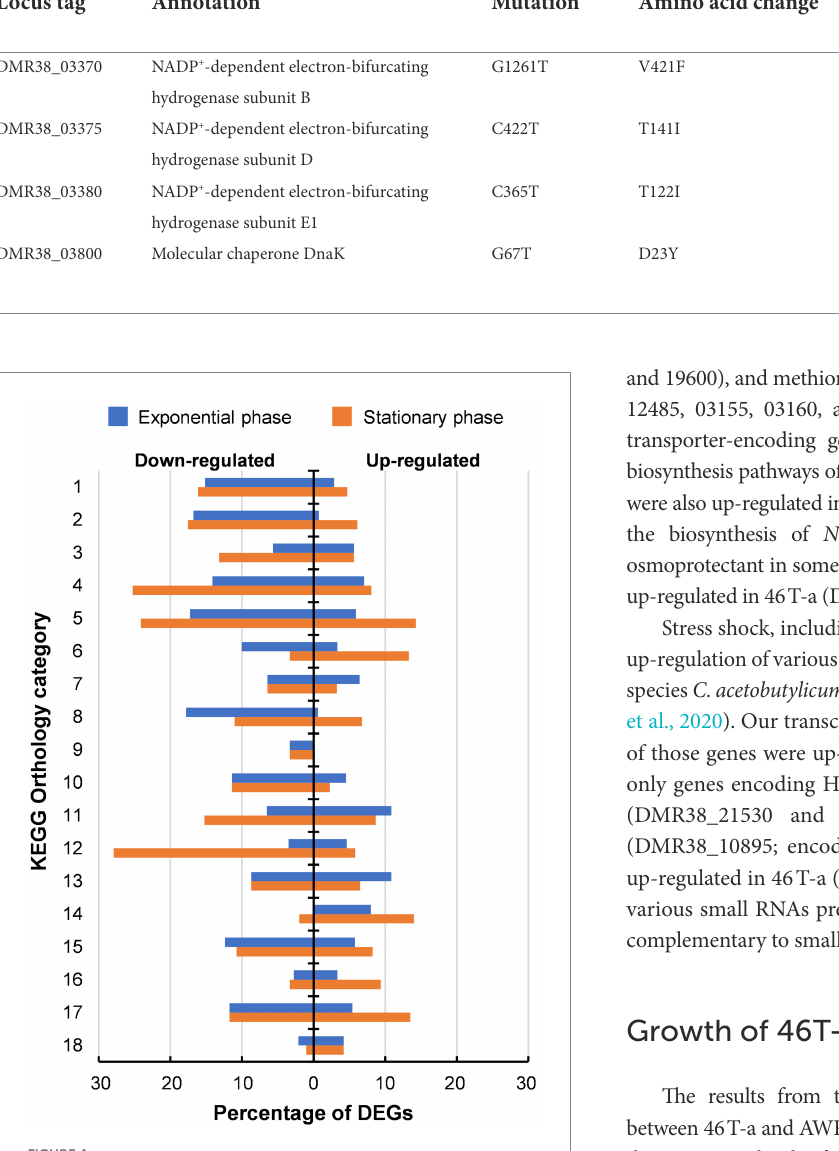
TABLE 1 Mutations identified in the 46 T-a genome. Locus tag